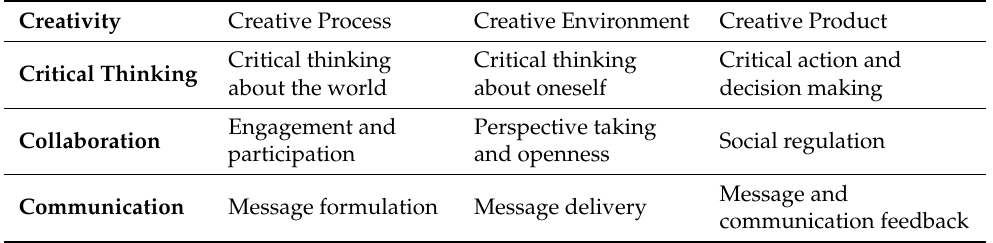
Table 1. Three different components of each C in IICD’s 21st Century Skills 4Cs Assessment Framework.